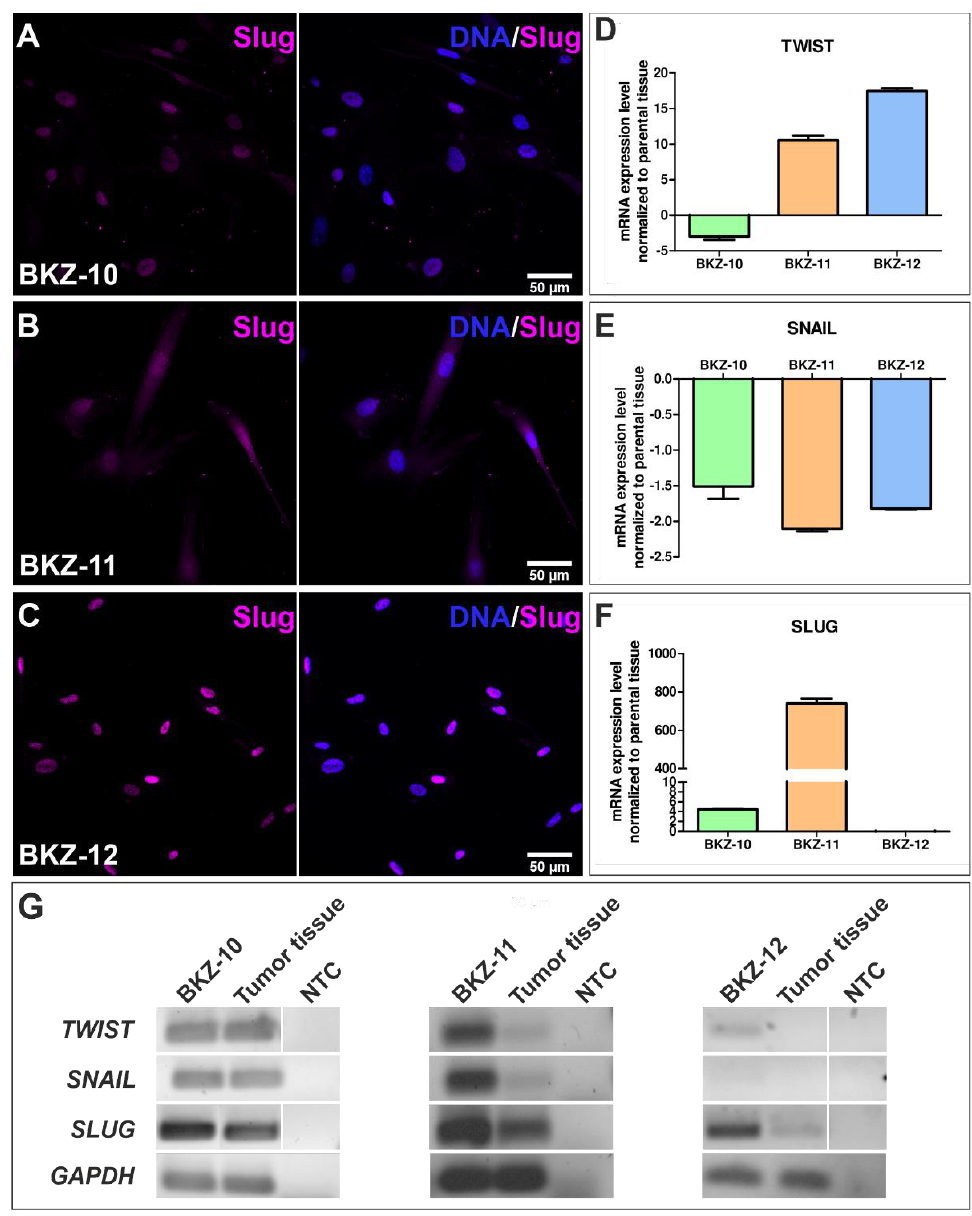
Figure 3. Endometrial carcinoma-derived stem-like cells express the epithelial-to-mesenchymal markers Twist, Snail and Slug. Immunocytochemical staining of Slug revealed a moderate nuclear protein expression in ( A ) BKZ-10 and ( B ) BKZ-11 as well as a high nuclear expression in ( C ) BKZ-12. Quantitative real-time PCR analysis of mRNA expression level normalized to the respective parental tissue mRNA expression level showed ( D ) enhanced TWIST expression for BKZ-11 as well as BKZ-12 and reduced expression for BKZ-10, ( E ) reduced SNAIL expression for all ECSC-populations and ( F ) enhanced SLUG expression for BKZ-10 and BKZ-11. Reverse transcriptase PCR ( G ) showed the mRNA expression of TWIST, SNAIL and SLUG for BKZ-10 and BKZ-11 and their respective parental tumor tissue, as well as TWIST and SLUG expression for BKZ-12 and SLUG expression for the parental tumor tissue of BKZ-12.